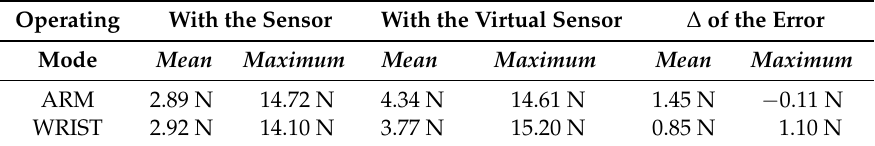
Table 3. Mean and maximum errors of the force controller with variable force